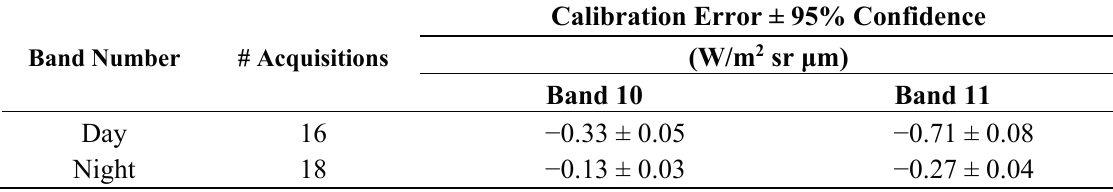
Table 2. Calibration error for both TIRS bands from the JPL data, spilt into day and night acquisitions. There is a statistically significant difference between the day and night results.